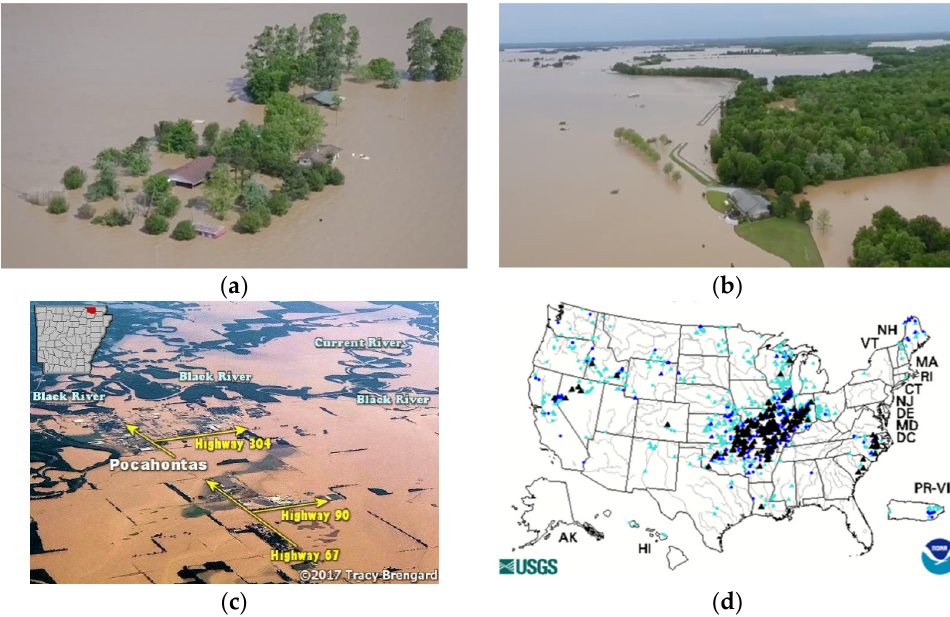
Figure 12. Two images ( a , b ) extracted from an aerial video and distributed by KATV News of the flooding and levee breaks near Pocahontas. Levee breaches were confirmed along the Black River, resulting in massive flooding on the east side of Pocahontas, Arkansas, and the surrounding area. Video can be found at [62]. Image ( c ) shows Pocahontas (Randolph County) and surrounding areas were inundated with water from an overflowing Black River (and failed levees along the river) on